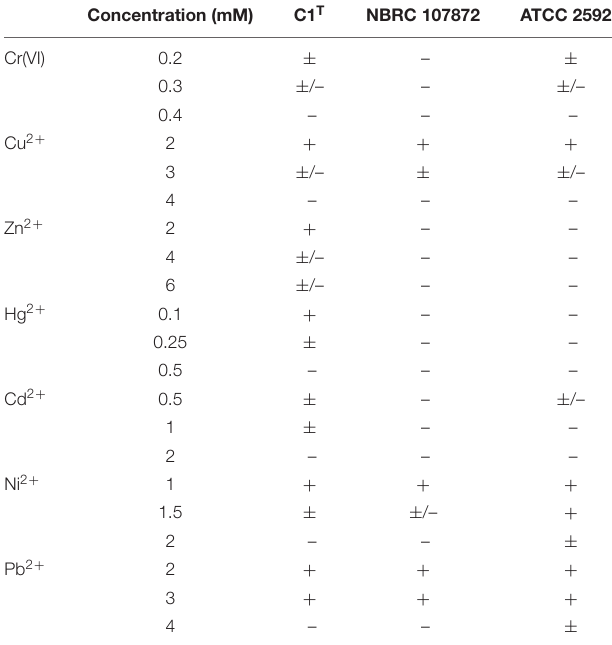
TABLE 2 | Heavy metal resistance of strains C1 T , NBRC 107872 and ATCC25922. Concentration (mM) C1 T NBRC 107872 ATCC 25922